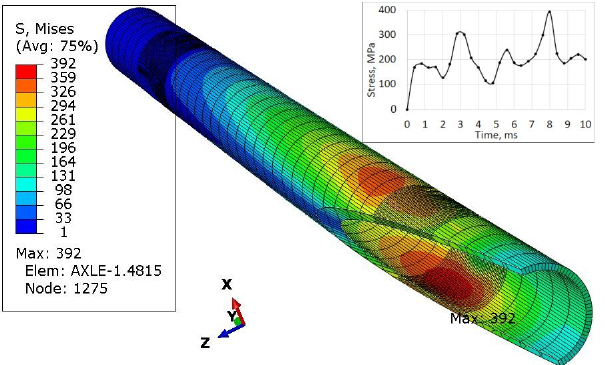
Figure 12. Stress distribution in the axle and max strengthened node 1275 while left wheel passes the triangular road deformation.